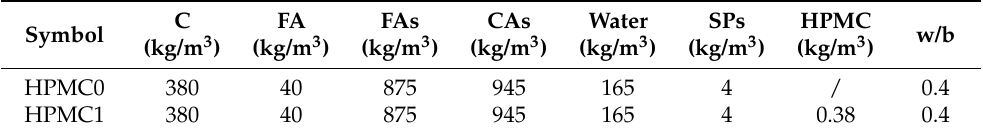
Table 3. Mixture